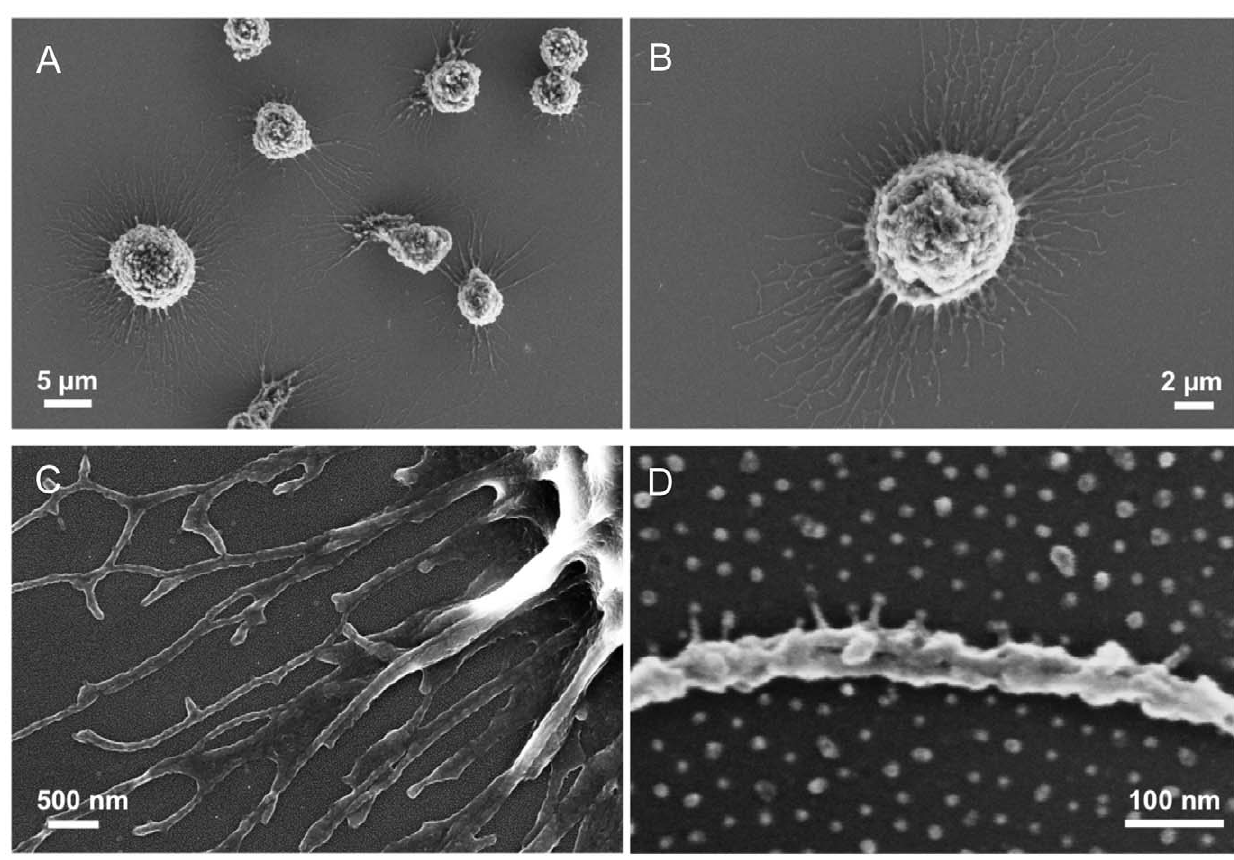
Figure 2. Cell morphology on nanostructured glass substrates. SEM images of critical point dried KG-1a cells on nanostructured, PEG- passivated, cRGD-functionalized substrates with interparticle distances of 36 6 7 nm. Magnification increases from A to D.